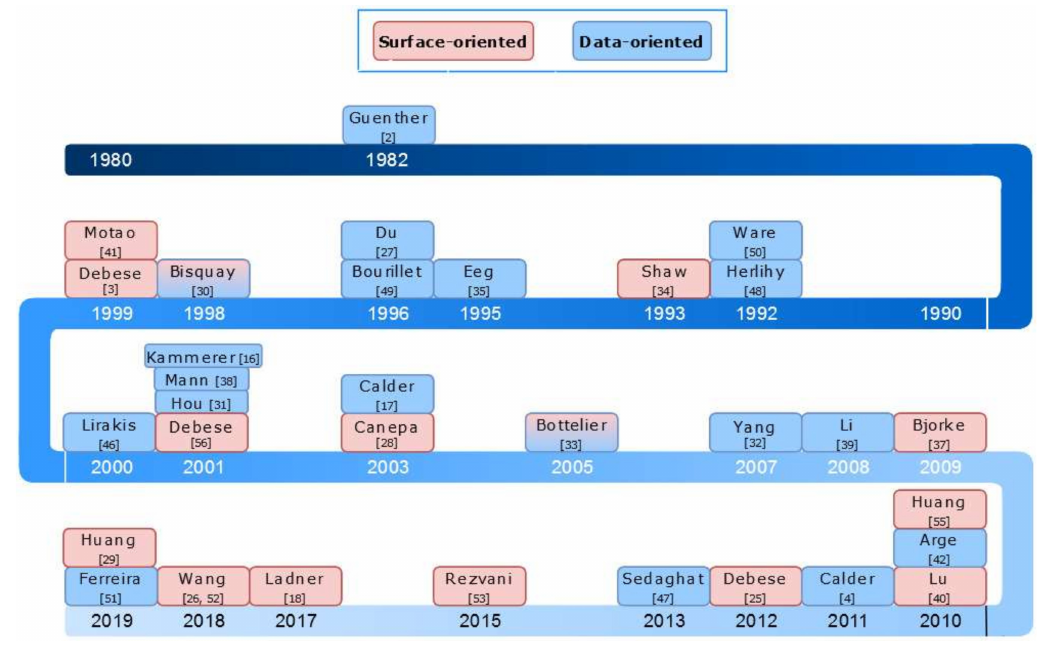
Figure 7. Timeline of the di ff erent approaches.